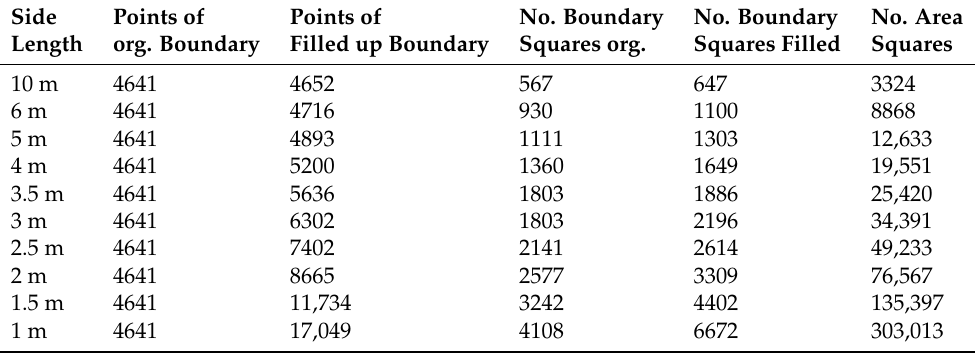
Table 1. With decreasing predefined side length in meters (column 1), the numbers of points needed to be filled to obtain solid boundary coordinates (column 3) as well as number of squares covering the boundary (column 5) and the area of observation (column 6) increased quadratically.